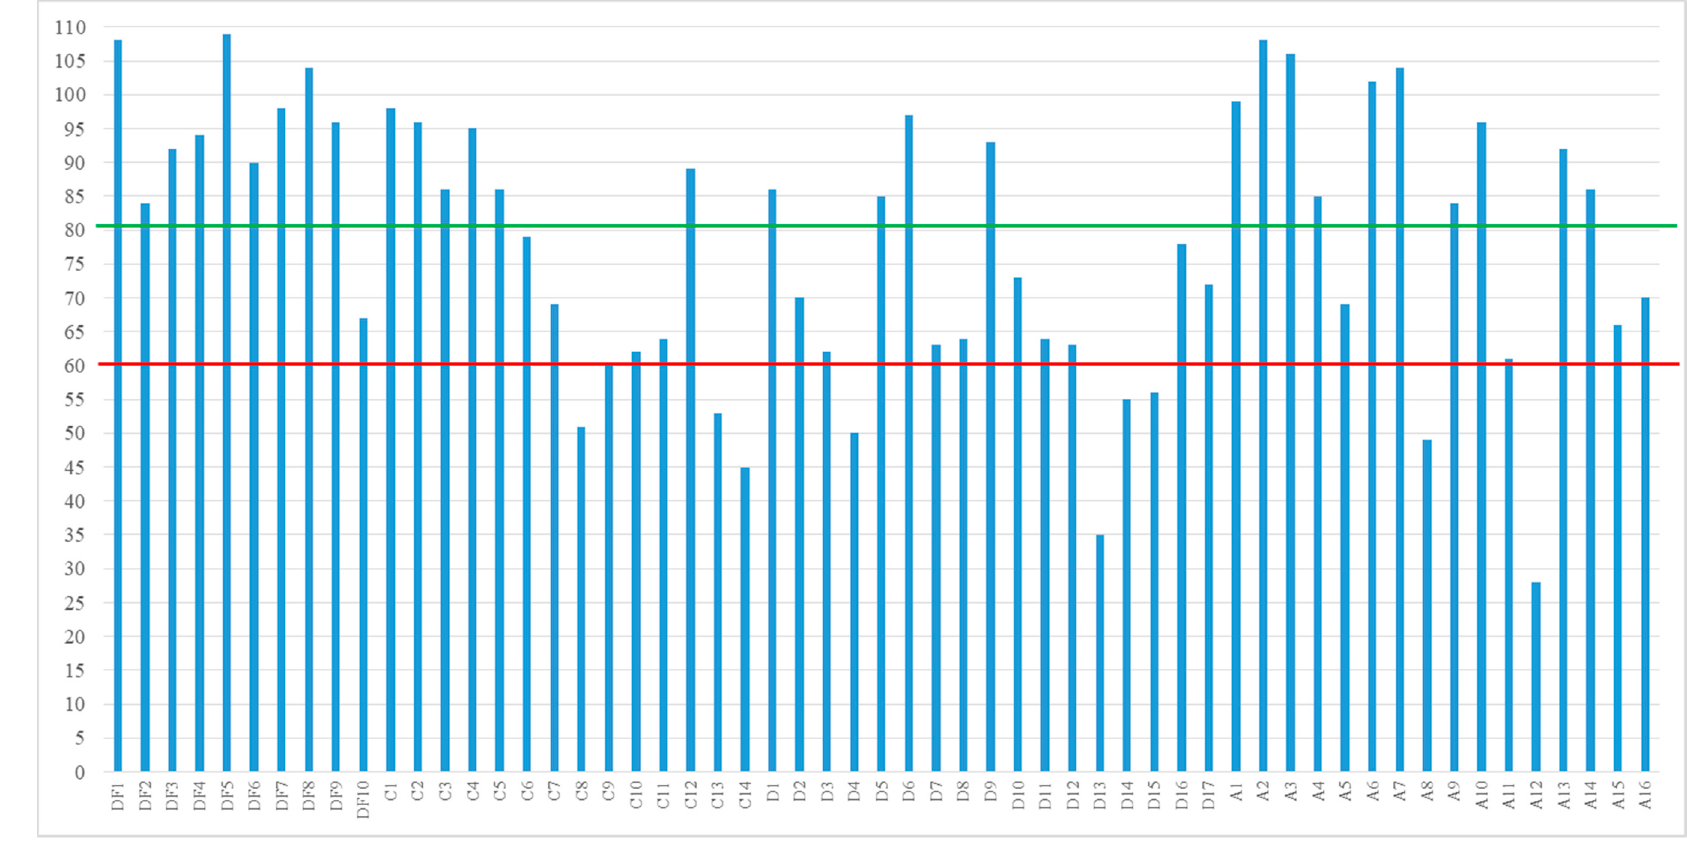
Figure 4. RW decision factors validated based on interviewees’ feedback.